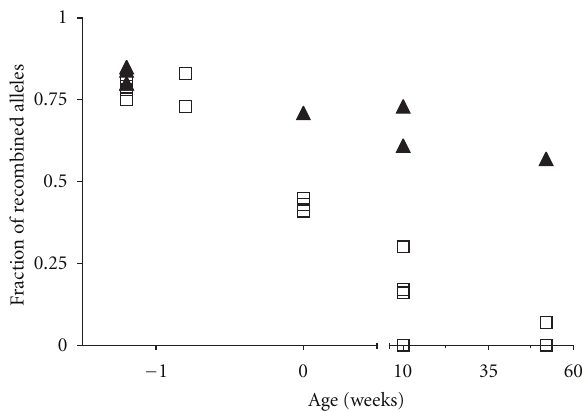
Figure 1: Recombination in Ercc1-flox Tie2-Cre model. The fraction of recombined alleles in the presence of Tie2-Cre was calculated after measuring the nondeleted floxed allele by real-time genomic PCR and comparing it to the presence of the floxed allele in absence of Cre. HPRT was measured to control for total DNA. DNA was isolated from fetal livers at embryonic days E12.5 and E15.5, from the spleen of neonatal mice, and from bone marrow of 10- and 52-week-old mice. Closed triangles: Tie2-Cre; Ercc1 + /f , open boxes: Tie2-Cre; Ercc1 − /f . Each symbol is an independent measurement.